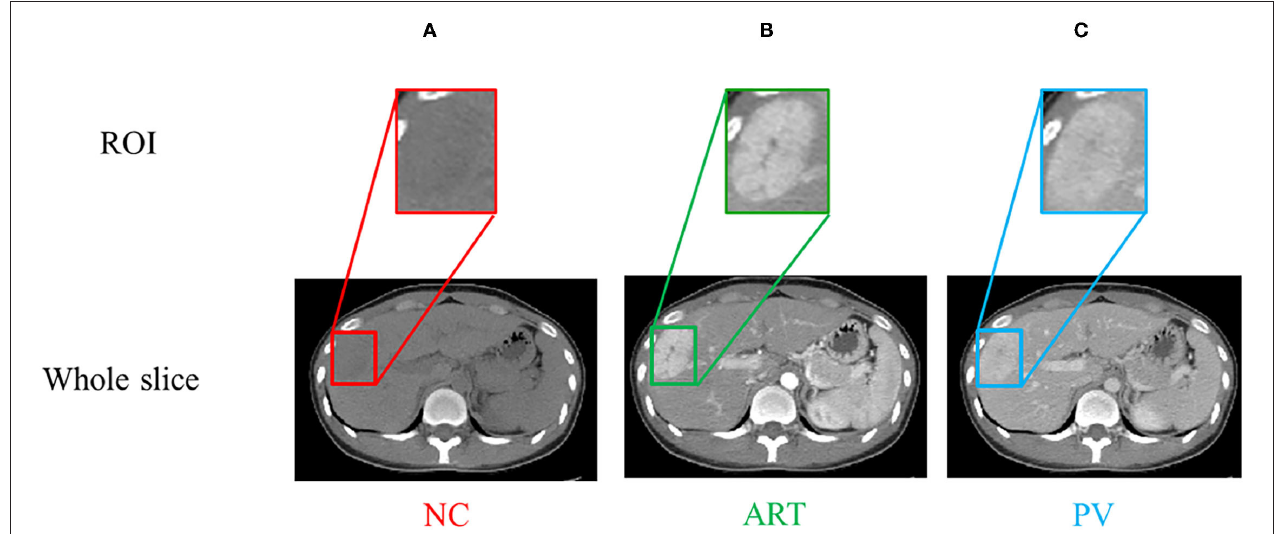
FIGURE 1 | (A–C) are NC, ART, PV phases, respectively. The region of interest (ROI) is the bounding box of the tumor.